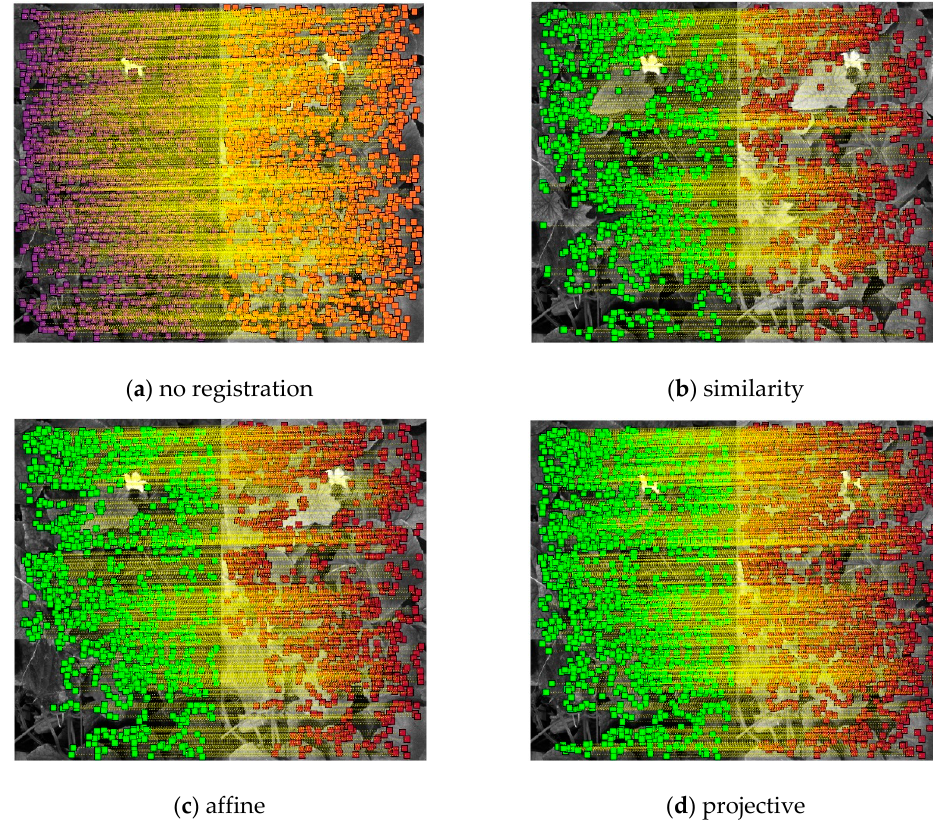
Matching point connector between the green and red-edge images; ■ Matching point in the green band image; ■ Matching point in the red-edge band image; ■ Inlier matching point in the green band image; ■ Inlier matching point in the red-edge band image. Figure 8. Comparison between the distribution of the total number of matching points and the inliers matching points for the MicaSense ® RedEdge green and red-edge band images in the case of the following geometric transformations: no registration ( a ), similarity ( b ), affine ( c ), and projective ( d ). Outliers matching points were detected using the M-estimator Sample Consensus (MSAC) algorithm.